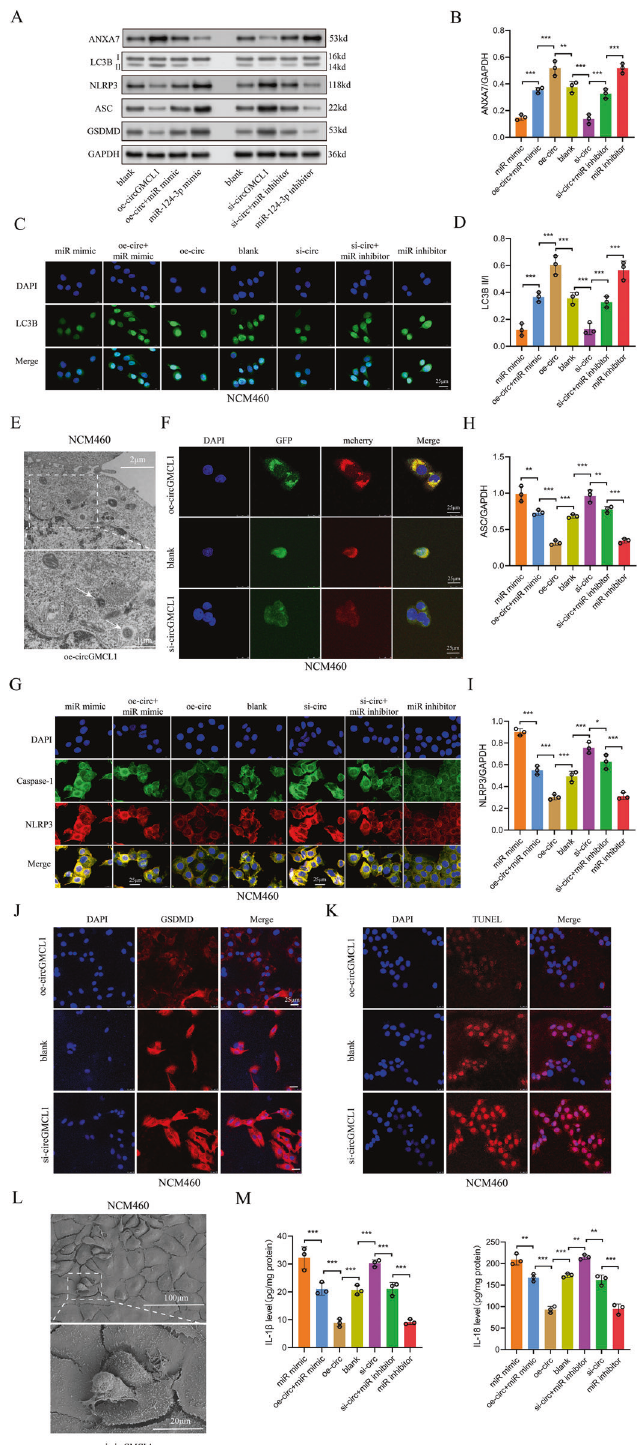
Fig. 5 Biological functions of circGMCL1 in epithelial cells. A Results of western blotting showing protein levels of ANXA7, LC3B, NLRP3, ASC, and GSDMD. B Quantitative results of ANXA7 expression in western blotting test. Immuno fl uorescence ( C ) and quantitative analysis ( D ) of LC3B expression by western blotting in NCM460 cells. E Representative TEM images of the autophagosome in NCM460 cells transfected with oe-circcGMCL1. F Autophagy fl ux based on mCherry-GFP-LC3B retrovirus generation in NCM460 cells transfected with control, oe- and si- circGMCL1. G Immuno fl uorescence of NLRP3 and caspase-1 in NCM460 cells. Quantitative analysis of ASC H and NLRP3 I following western blotting test in NCM460 cells. GSDMD immuno fl uorescence ( J ) and TUNEL ( K ) assays in NCM460 cells. Representative pyroptosis SEM image ( L ). Proin fl ammatory cytokines (IL-1 β and IL-18) in NCM460 cells M . QRT-PCR quantitative real time-polymerase chain reaction, ANXA7 annexin 7, TEM transmission electron microscope. Data are presented as mean ± SD. ** P < 0.01, *** P < 0.001 by one-way ANOVA test.